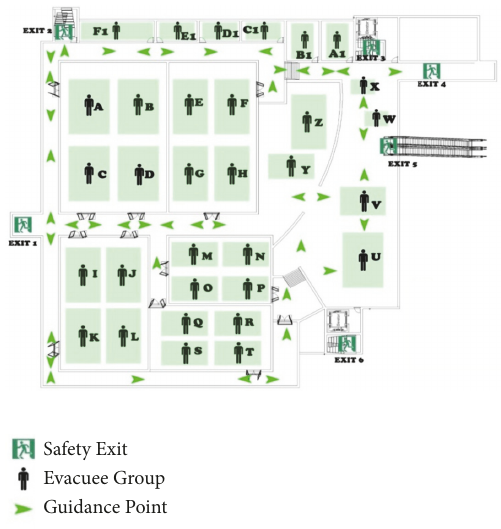
Figure 2: Floor plan of cinema in